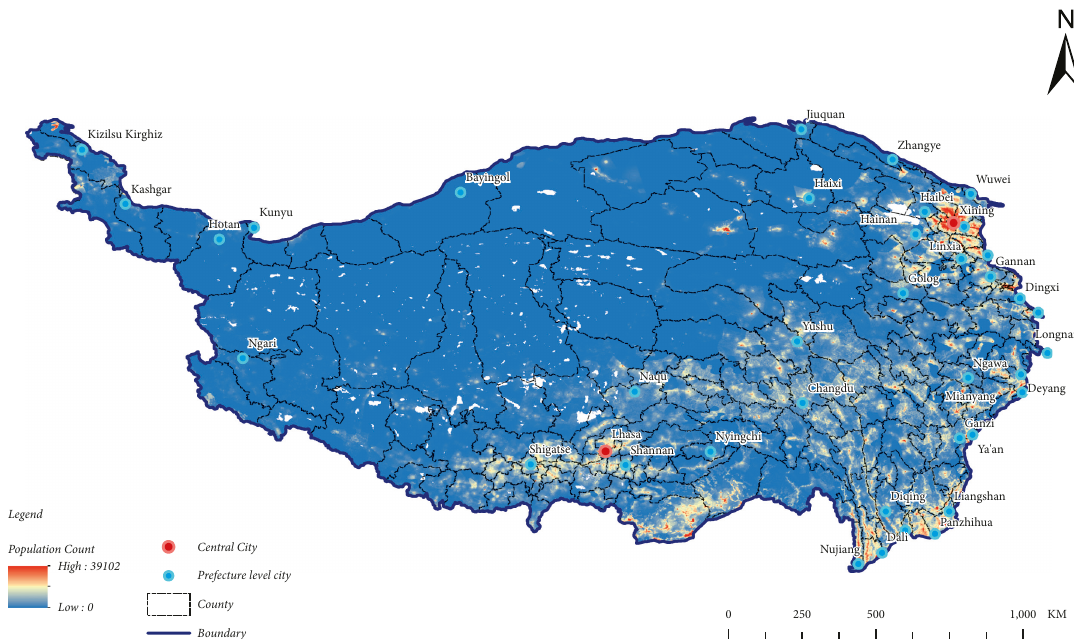
Figure 4: Population distribution of the Qinghai-Tibet